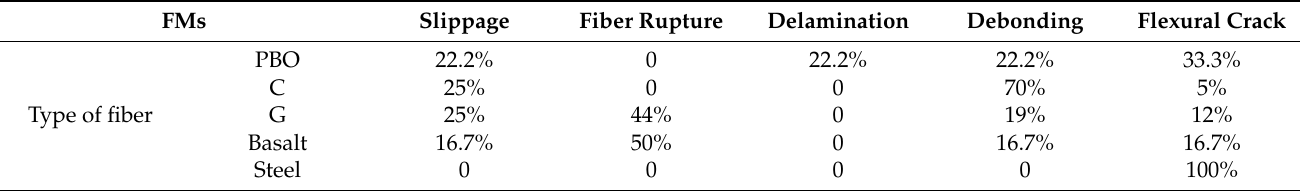
Table 6. The percentage of FMs based on the type of